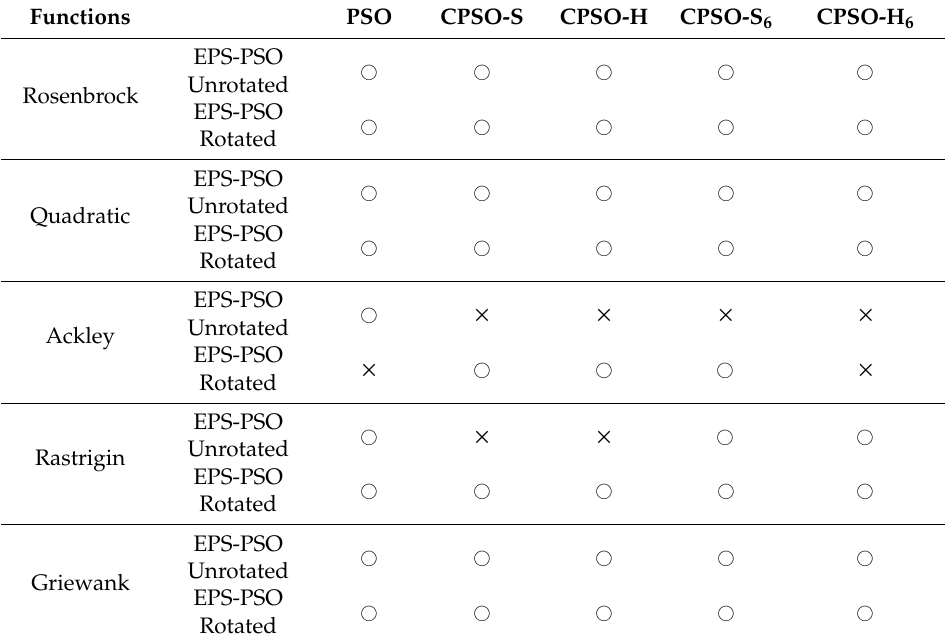
Table 7. The performance comparisons between the proposed EPS-PSO algorithm and five different PSO variants over five benchmark functions.